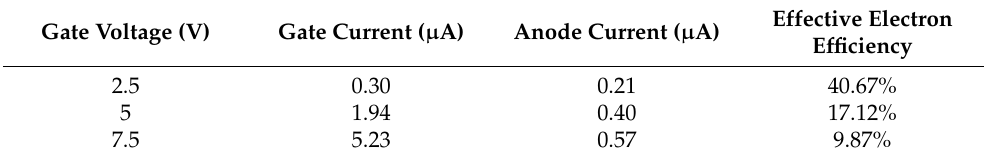
Table 1. Performance of the NVC electron source at a fixed anode voltage of 50 V.